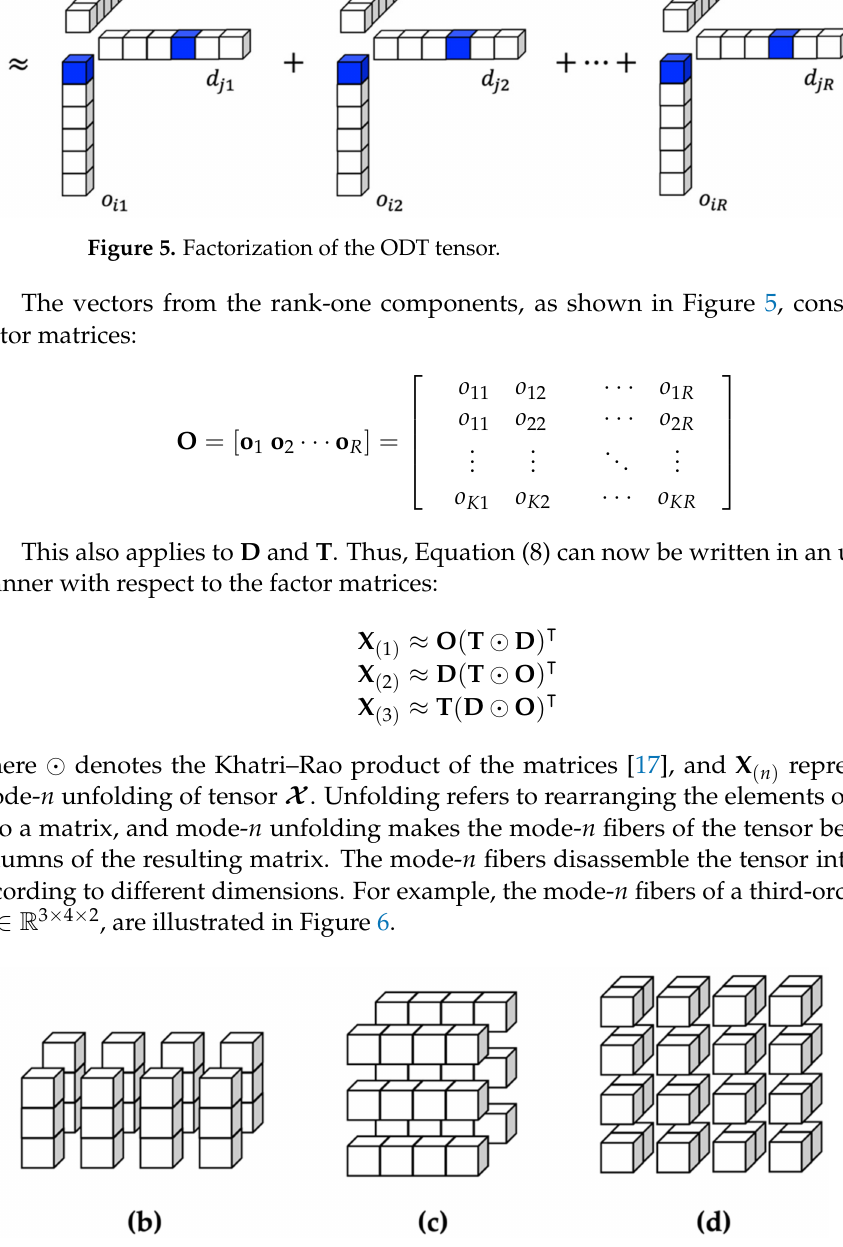
Figure 6. Illustration of mode- n fibers of a tensor: ( a ) example tensor Y ; ( b ) mode-1 (column) fibers of Y ; ( c ) mode-2 (row) fibers of Y ; and ( d ) mode-3 (tube) fibers of Y